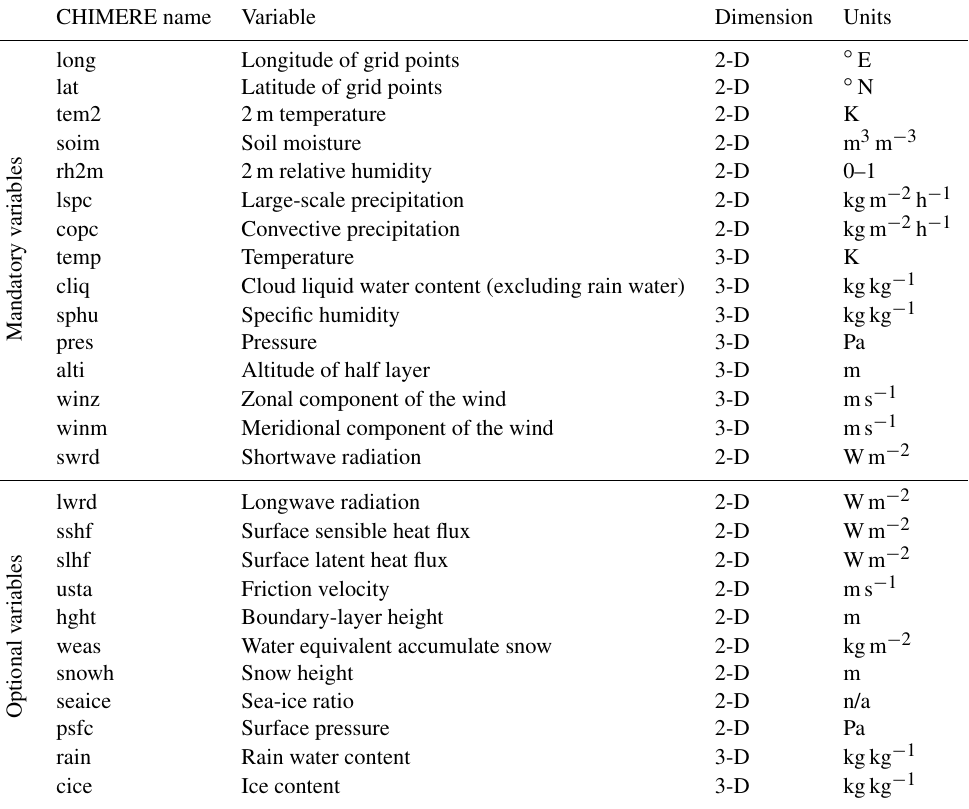
Table 1. Mandatory and optional variables obtained from meteorological input data. If the optional variables are not provided by the raw meteorological model, there are diagnosed during the simulation.